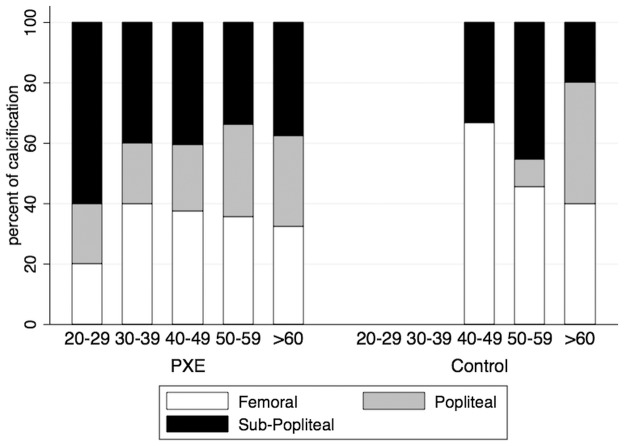
Prevalence of lower limb arterial calcification (LLAC) detected in arterial segments in pseudoxanthoma elasticum (PXE) and controls across age.Data are expressed as percentage of the total number of LLAC detected in a given age group.